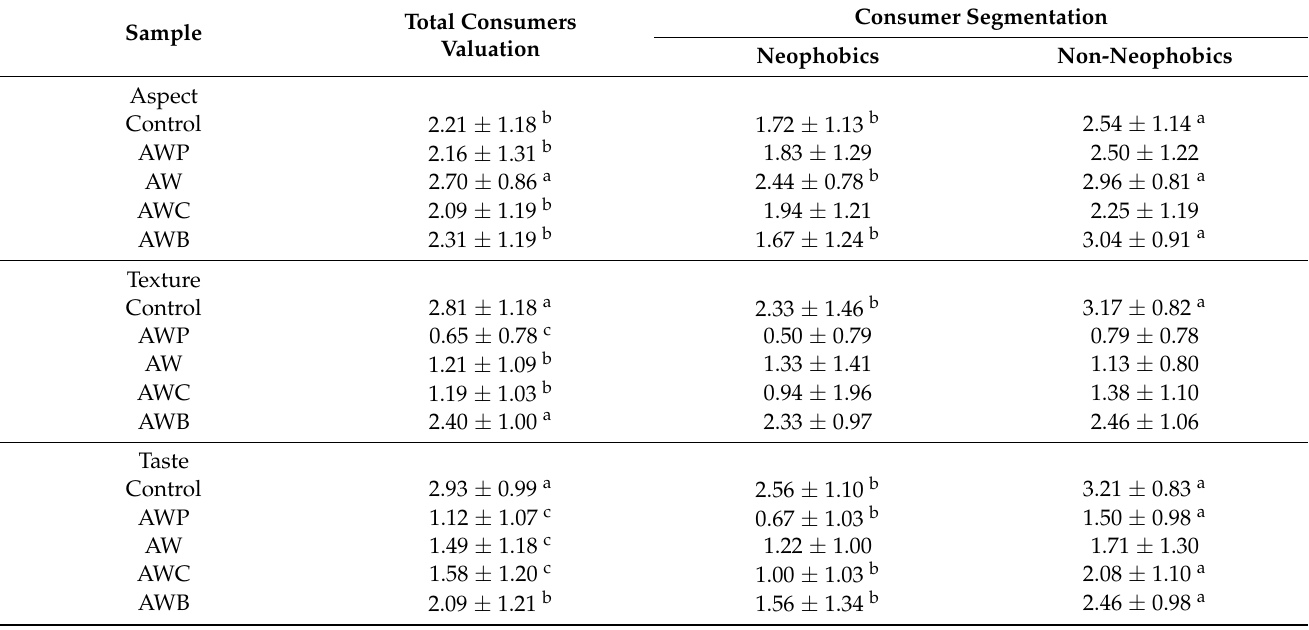
Table 7. Sensory analysis and consumer segmentation attending to the Food Neophobia